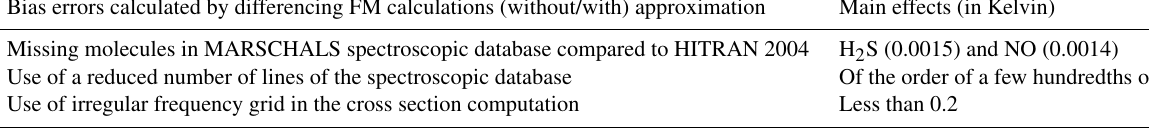
Table 2. MARSCHALS systematic errors: bias and parameter errors. Bias errors calculated by differencing FM calculations (without/with) approximation Main effects (in Kelvin) Missing molecules in MARSCHALS spectroscopic database compared to HITRAN